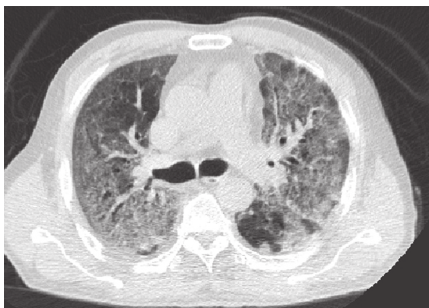
Figure 3: Diffuse consolidation in a case at the peak phase re- sembling